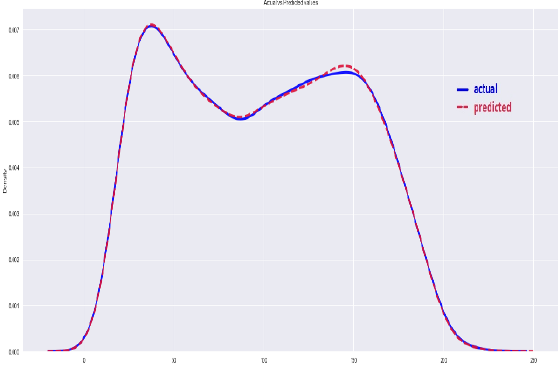
Fig. 8. Actual vs Predicted for Maximum Power using Random Forest Fig. 5. Actual vs Predicted for Module Temperature using